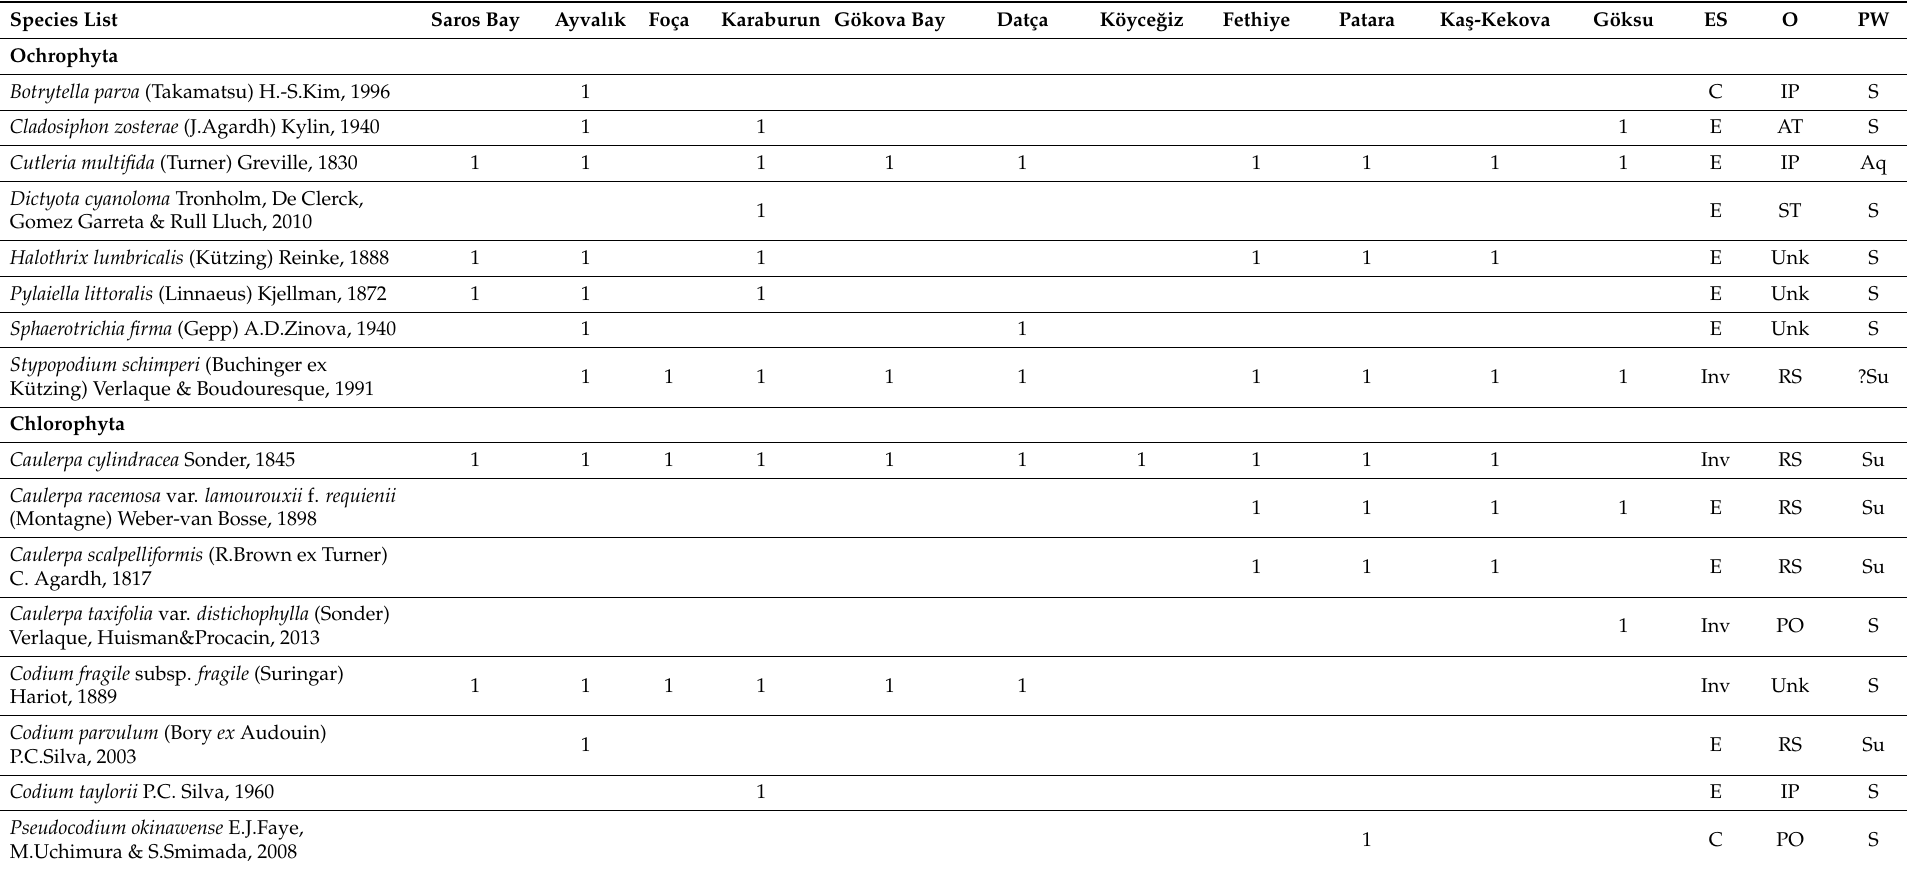
Table A1. Alien species inventory of Turkish MPAs. The sorting of the sites follows a counterclockwise direction, from the north Aegean to the northern Levantine Sea. Establishment Success (ES)—C: casual aliens, E: established aliens, Inv: invasive species; Origin (O)—IP: Indo-Pacific, RS: Red Sea, AT: Atlantic, NA: North Atlantic, WA: Western Atlantic, ST: Subtropical Atlantic/Pacific, IO: Indian Ocean, PG: Persian Gulf, PO: Pacific Ocean, TA: Tropical Atlantic, CT: Circumtropical, Unk: Unknown; Pathways (PW)—Aq: aquaculture, S: ships, Su: Suez Canal (corridor). Saros Bay Ayvalık Foça Karaburun Gökova Bay Datça Köyce˘giz Fethiye Patara Ka¸s-Kekova Göksu ES O PW